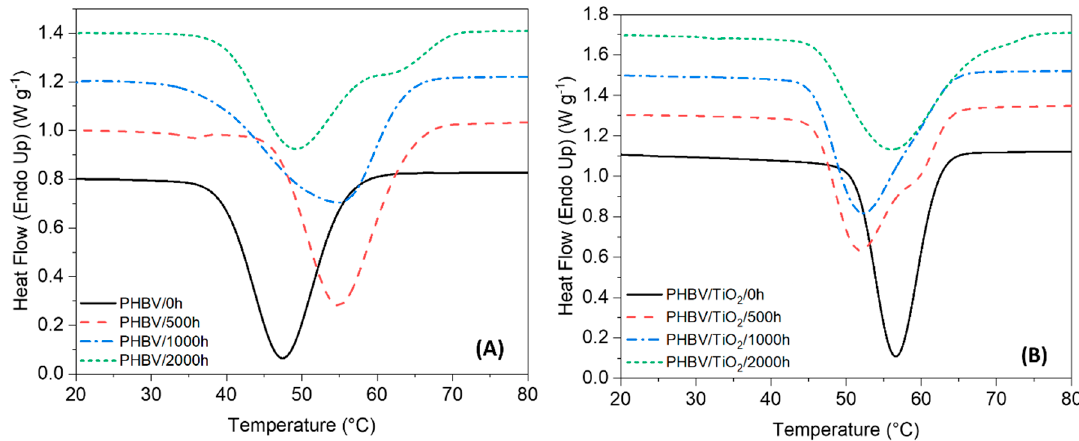
Table 2. DSC data obtained for the neat PHBV and the PHBV/TiO 2 nanocomposites after accelerated weathering degradation. Figure 9. DSC cooling curves of ( A ) the PHBV and ( B ) the PHBV / TiO 2 nanocomposites, before and Figure 9. DSC cooling curves of ( A ) the PHBV and ( B ) the PHBV/TiO 2 nanocomposites, before and after the di ff erent periods of accelerated weathering after the different periods of accelerated weathering degradation.